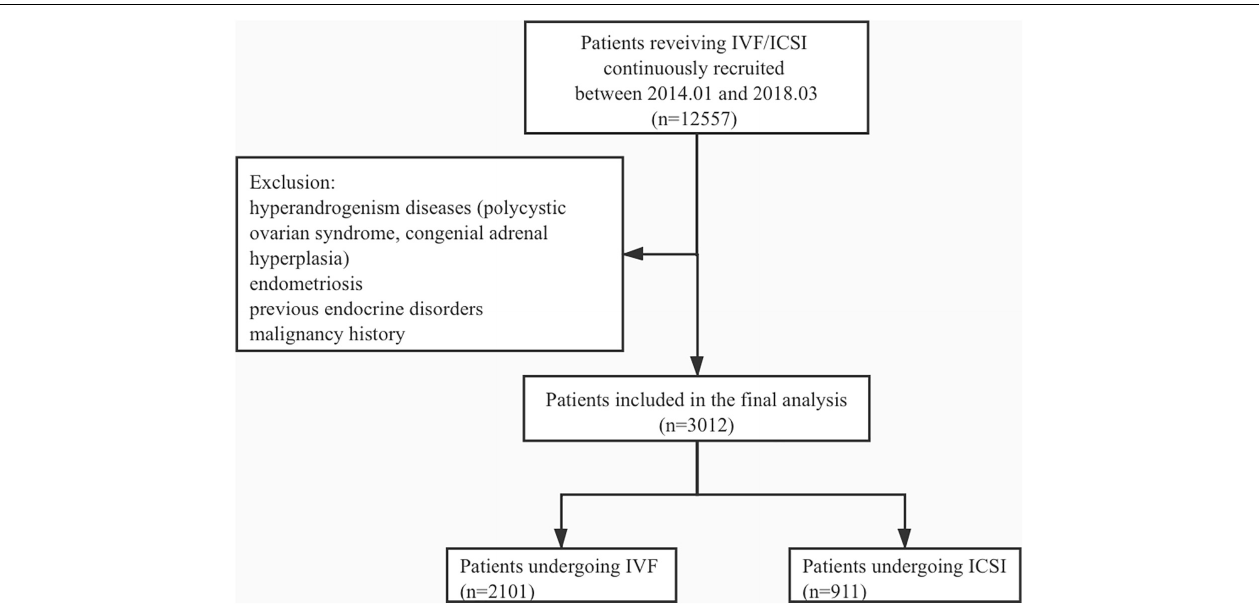
FIGURE 1 | The schematic of the study